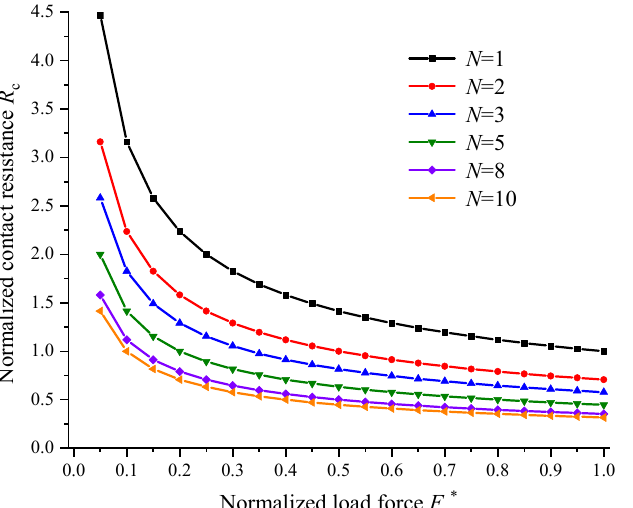
Figure 9. The variations in the minimum, average and maximum normalized contact resistance as a function of the number of contact a -spots.